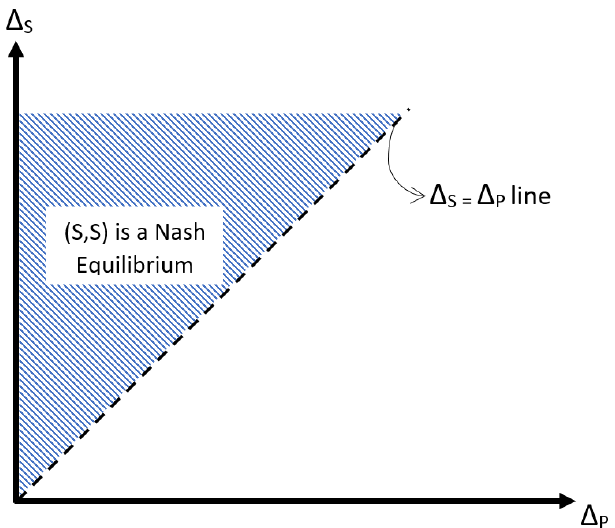
Figure 1. Equilibrium diagram for the S – P game with parameters ∆ S and ∆ P .